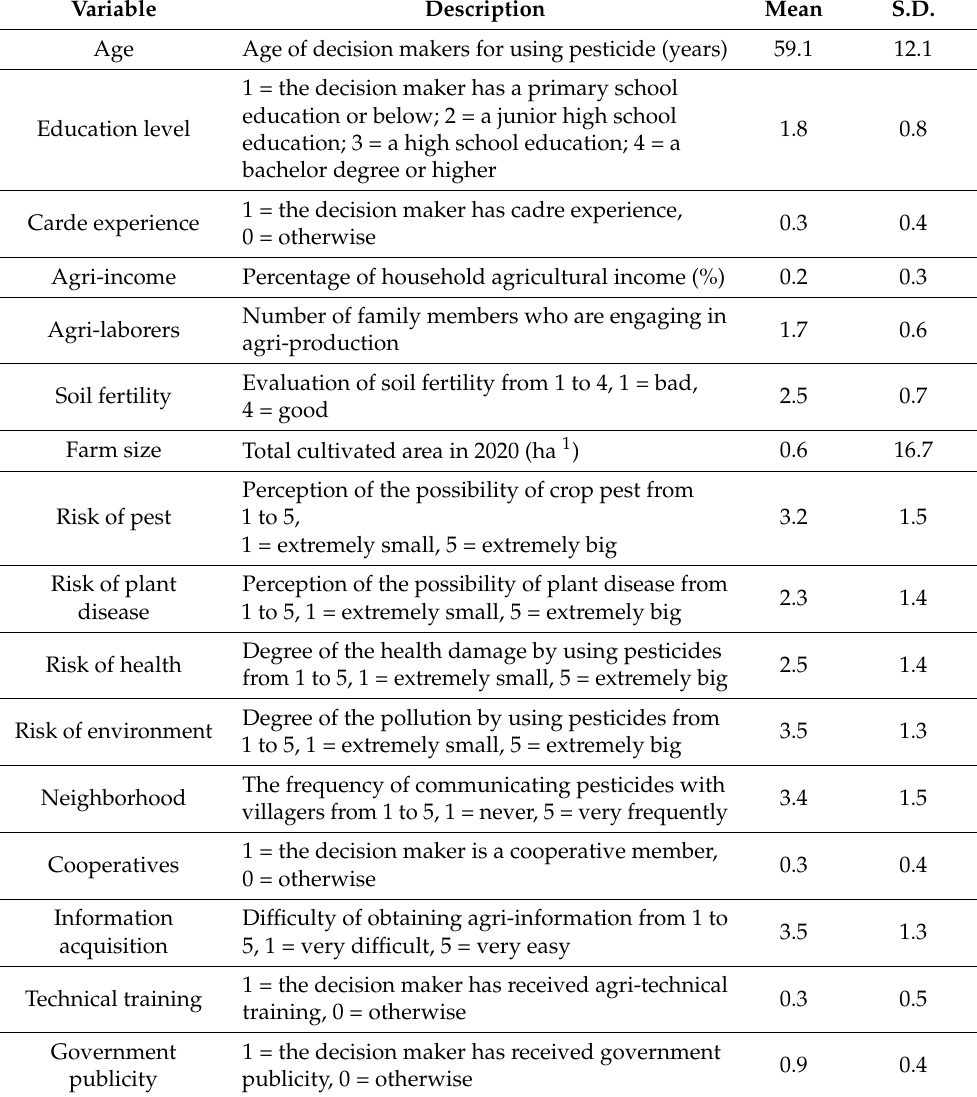
Table 2. Variable definitions and descriptive